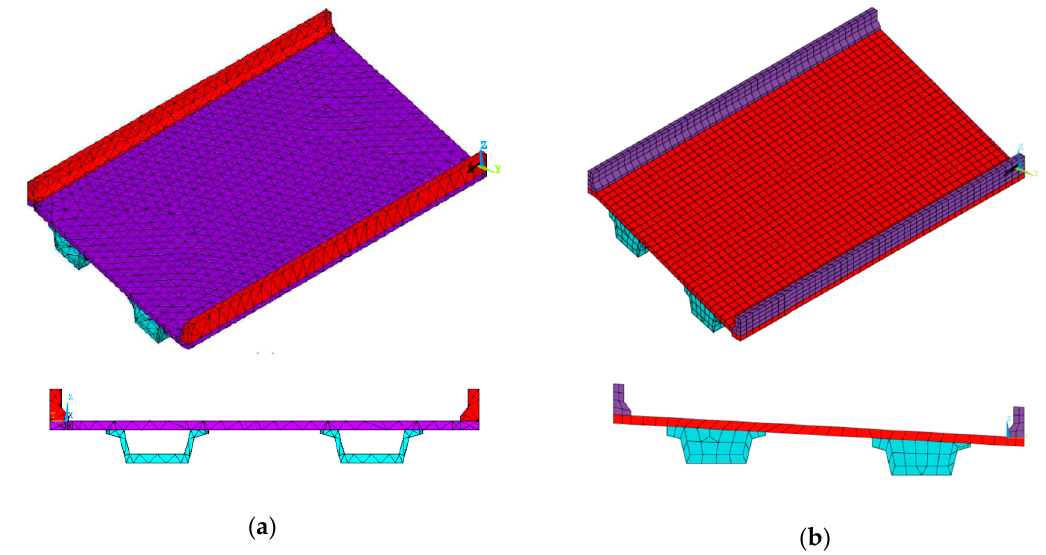
Figure 6. FE models built with 3D solid elements: ( a ) the initial model; ( b ) the manually tuned model.